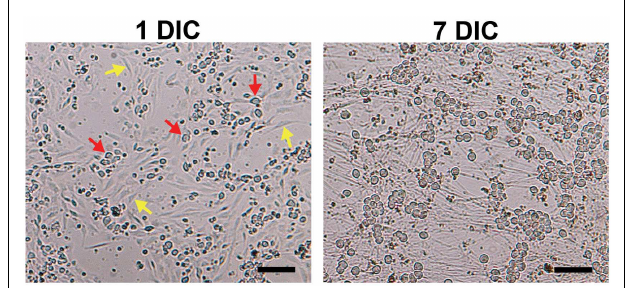
FIGURE 1 | Elimination of non-neuronal cells in DRG neuronal cultures. AlthoughThy 1.1 pre-plating alone did not completely remove non-neuronal cells (1 DIC, yellow arrows; red arrows, DRG neurons), it significantly reduced the amount of time DRG neurons spent in anti-mitotic media. Dissociated DRG neurons seeded at 50,000 cells/well in a 24-well Seahorse XF24 polystyrene microplate at 1 and 7 DIC at 5 × phase objective. Scale bar: 200 µ m.